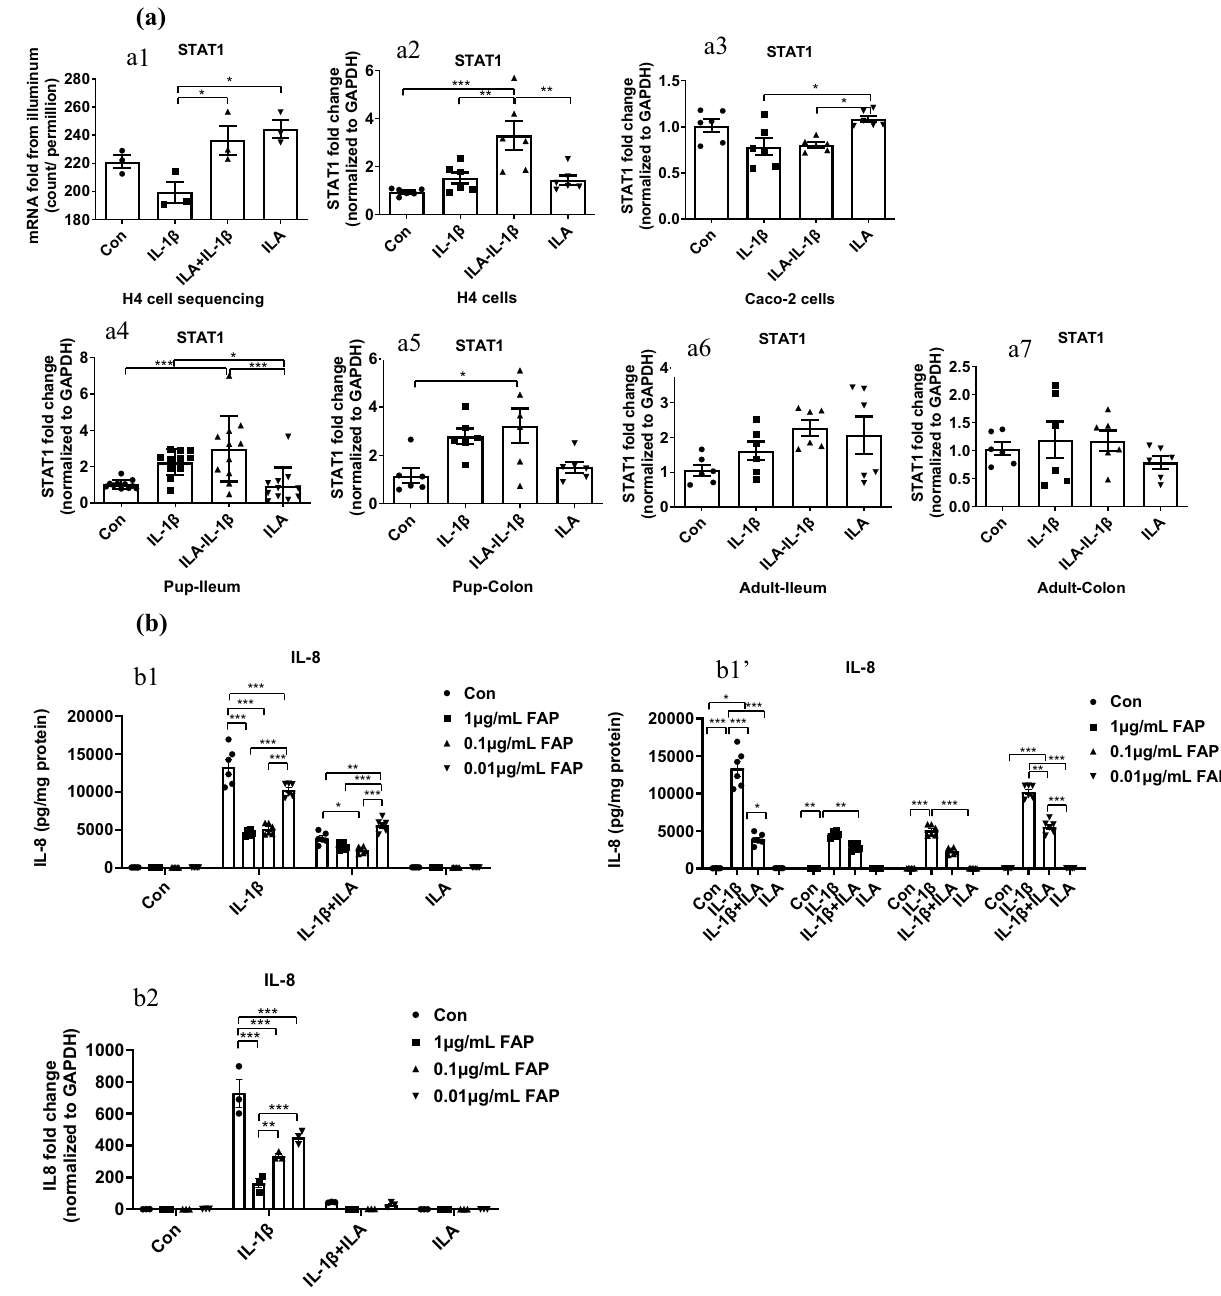
Figure 6. ILA inhibited the IL-1β-induced inflammatory response by regulating STAT1 signaling pathway. ( a ) STAT1 mRNA level analyzed by RNA sequencing using Illumina (a1) and validated by qRT PCR in H4 cells (a2). STAT1 mRNA expression in Caco-2 cells (a3), pup-ileum (a4) and colon (a5), adult ileum (a6) and colon (a7) were determined by qRT-PCR; ( b ) The different concentration of STAT1 inhibitor FAP decreased